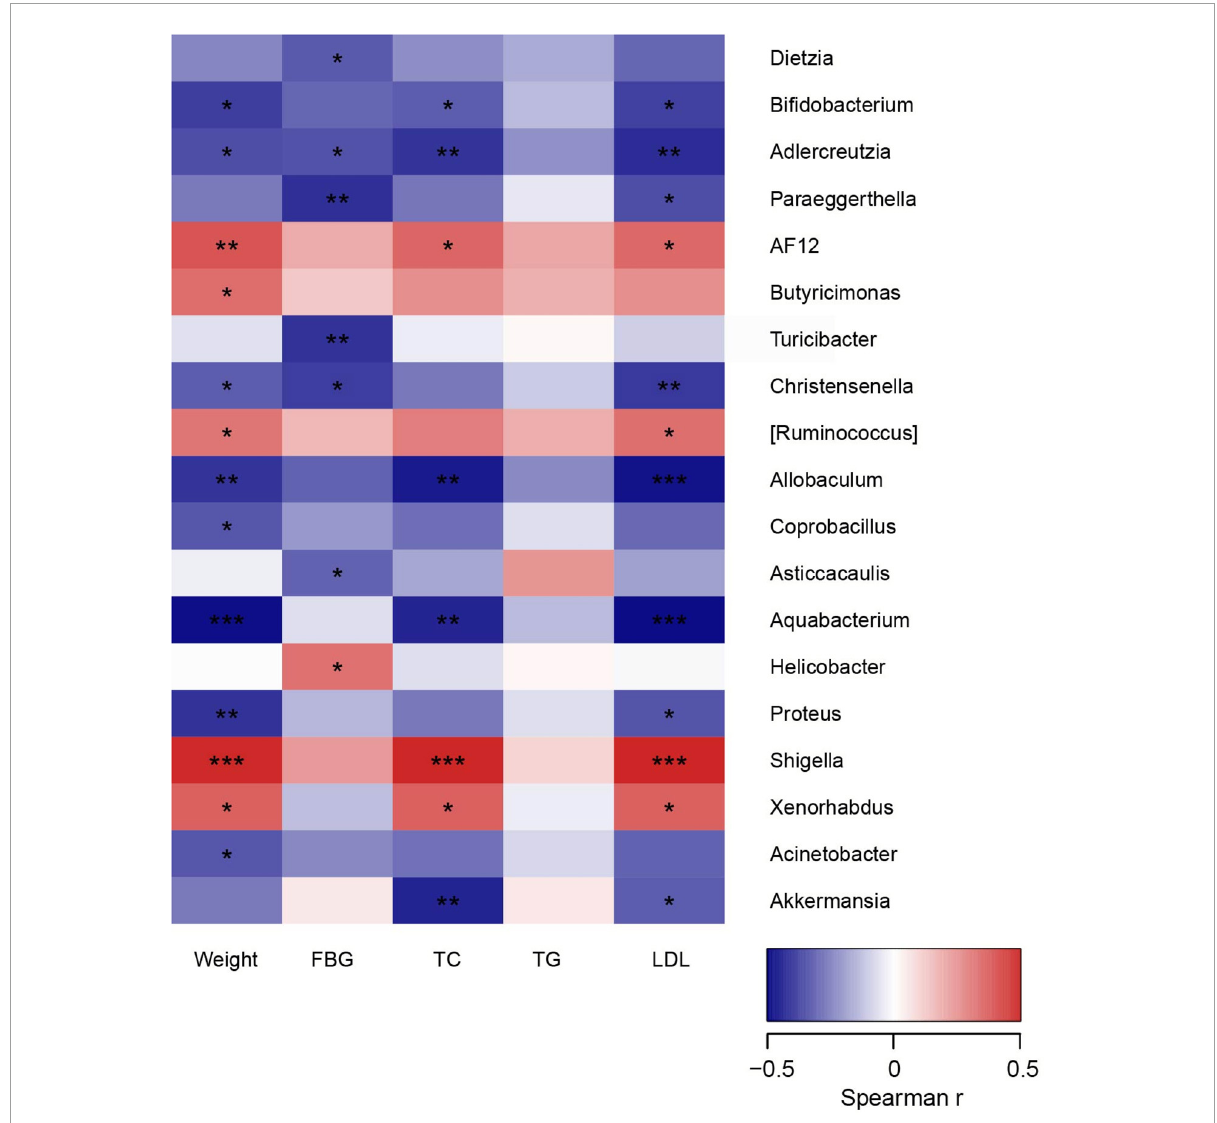
FIGURE5 The relationship between microbiota composition and metabolic parameters. * p < 0.05, ** p < 0.01, and *** p <